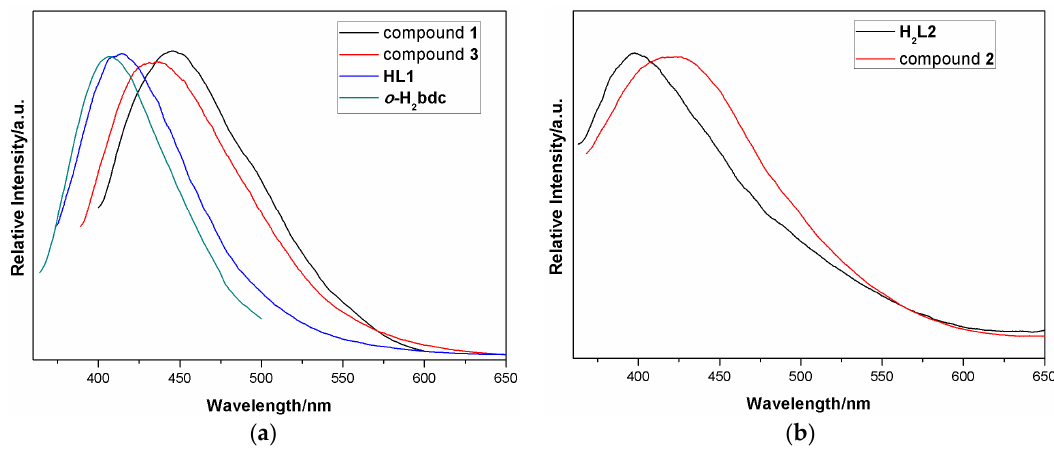
Figure 4. ( a ) Solid-state luminescent spectra of compound 1 , 3 , HL1, and o-H 2 bdc; ( b ) Solid-state luminescent spectra of compound 2 and H 2 L2.